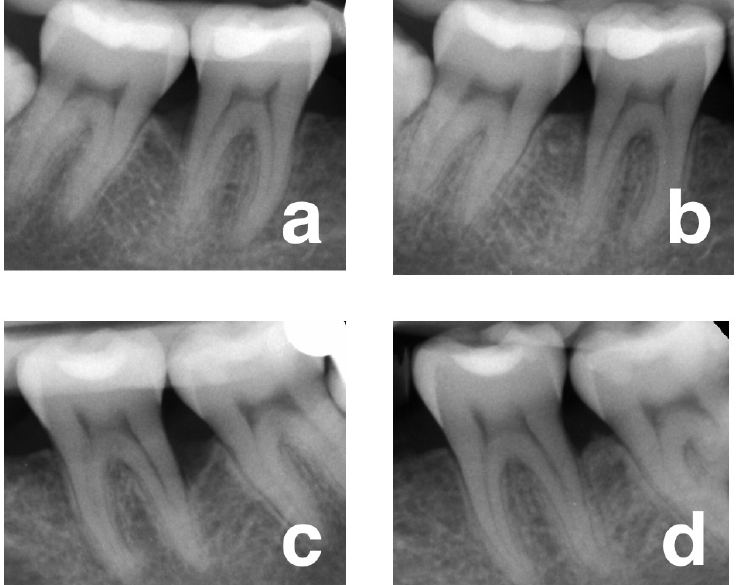
Figure 3. ( a ) Baseline radiograph of the intra-bony defect on the distal surface of tooth 46 (test site). ( b ) Radiograph at 12 months post-surgery. ( c ) Baseline radiograph of intra-bony defect on the distal surface of tooth 36 (control site). ( d ) Radiograph at 12 months post-surgery.